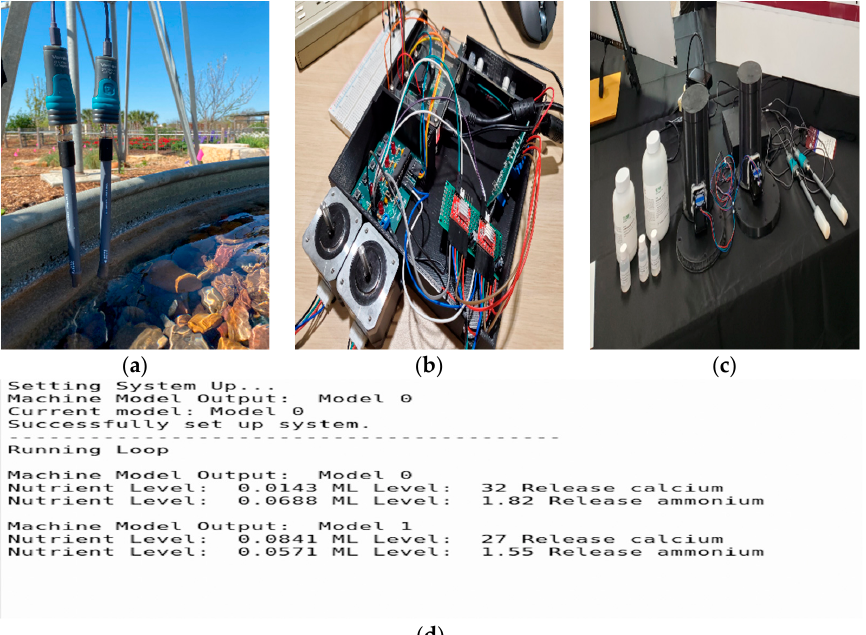
Figure 7. ( a ). A set-up of the Vernier sensors to measure calcium and ammonium; ( b ). a set-up of